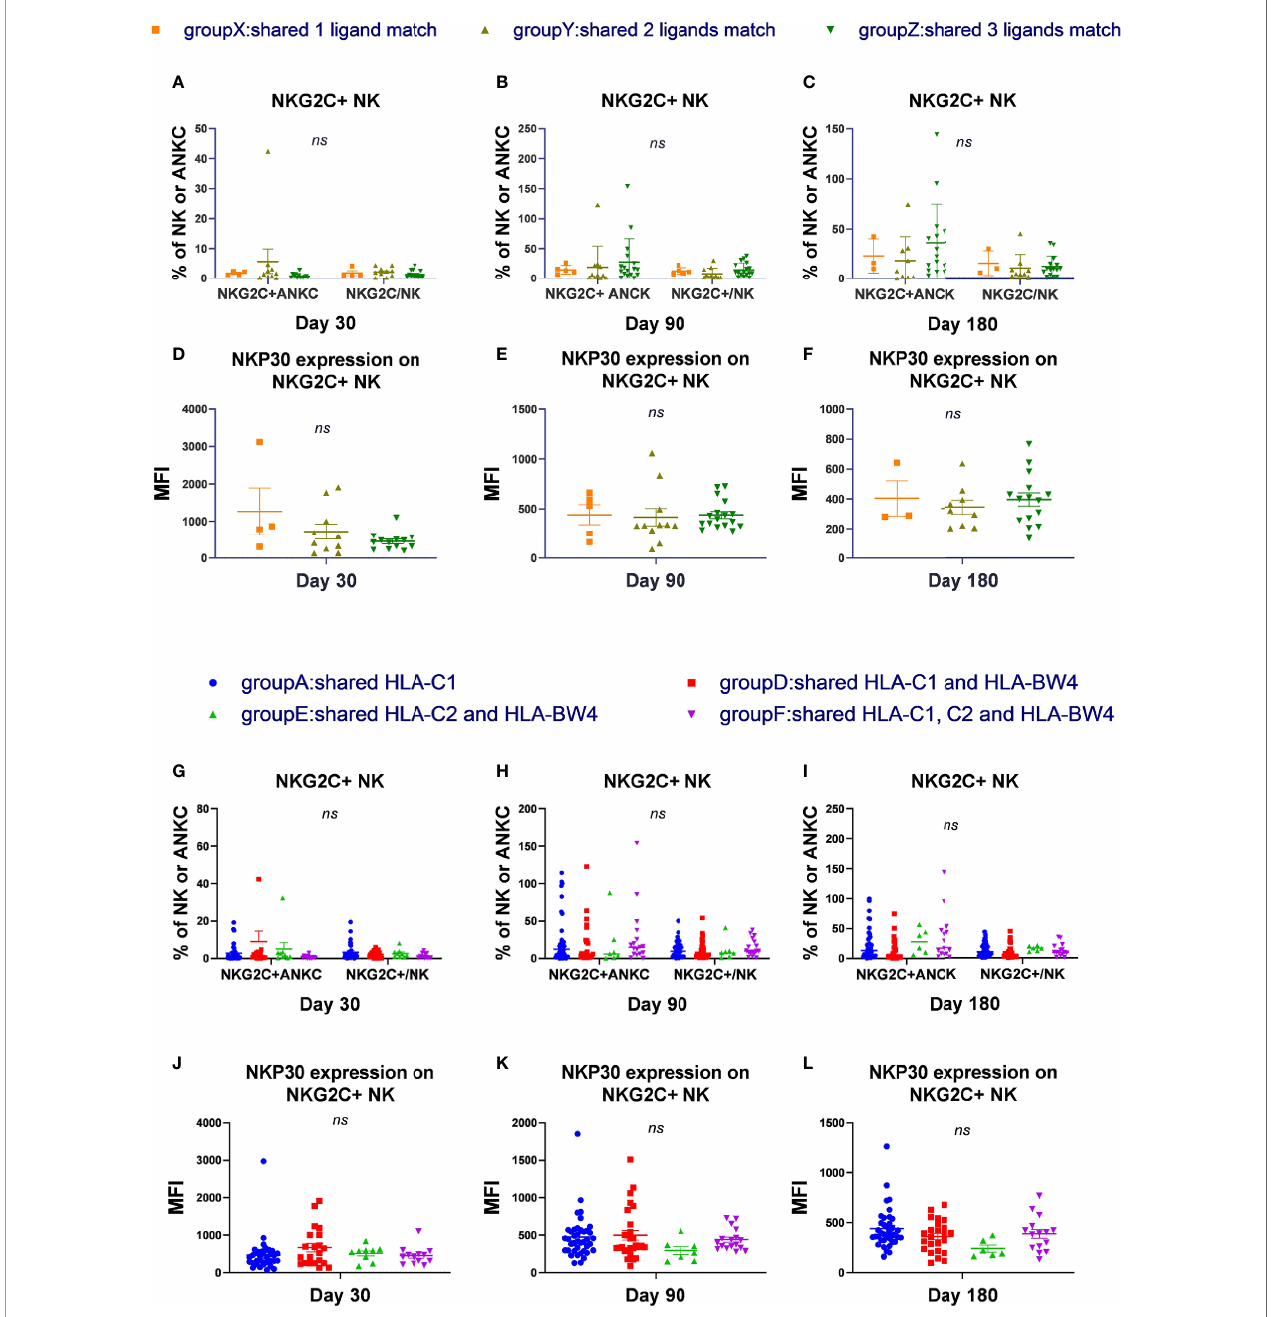
FIGURE 1 | The number and types of KIR ligands shared by donors and recipients has no effect on NKG2C expansion and reactivity. According to the number of HLA-C donors and recipients both shared, we divided the patients into 4 groups, group W to group Z and excluded group W. According to the types of matches of donor-patient HLA-C, we divided all the patients in the cohort into 6 groups and excluded groups B and C. (A – C) The proportion of NKG2C+ NK cells among NK cells and the absolute number of NKG2C+ NK cells (ANKC, absolute NK count) from patients after HSCT in group X (day 30, n = 4; day 90, n = 5; day 180, n = 3), group Y (day 30, n = 10; day 90, n = 11; day 180, n = 9), and group Z (day 30, n = 13; day 90, n = 17; day 180, n = 15). (G – I) The proportion of NKG2C+ NK cells among NK cells and the absolute number of NKG2C + NK cells (ANKC, absolute NK count) from patients after HSCT in group A (day 30, n = 35; day 90, n = 40; day 180, n = 38), group D (day 30, n = 21; day 90, n = 28; day 180, n = 24), group E (day 30, n = 9, day 90, n = 7, day 180, n = 6), and group F (day 30, n = 13, day 90, n = 17; day 180, n = 15). (D – F, J – L) The mean fl uorescence intensity (MFI) of NKp30 on NKG2C + /NKG2A - NK cells in groups X to Z and groups A, D, E, and F on days 30, 90, and 180. Each plot (triangle, circle, or square) shows one patient with the indicated receptor expression. The middle horizontal lines show the mean values for each group, and the upper and lower horizontal lines show the standard error of the mean. n.s., not signi fi cant (Kruskal – Wallis H